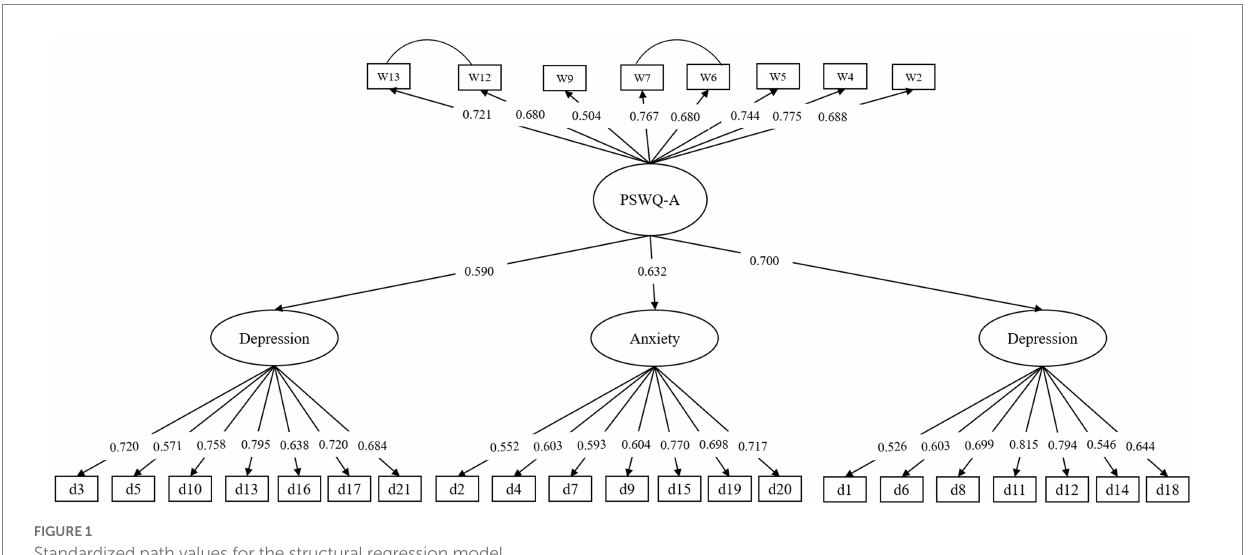
FIGURE 1 Standardized path values for the structural regression